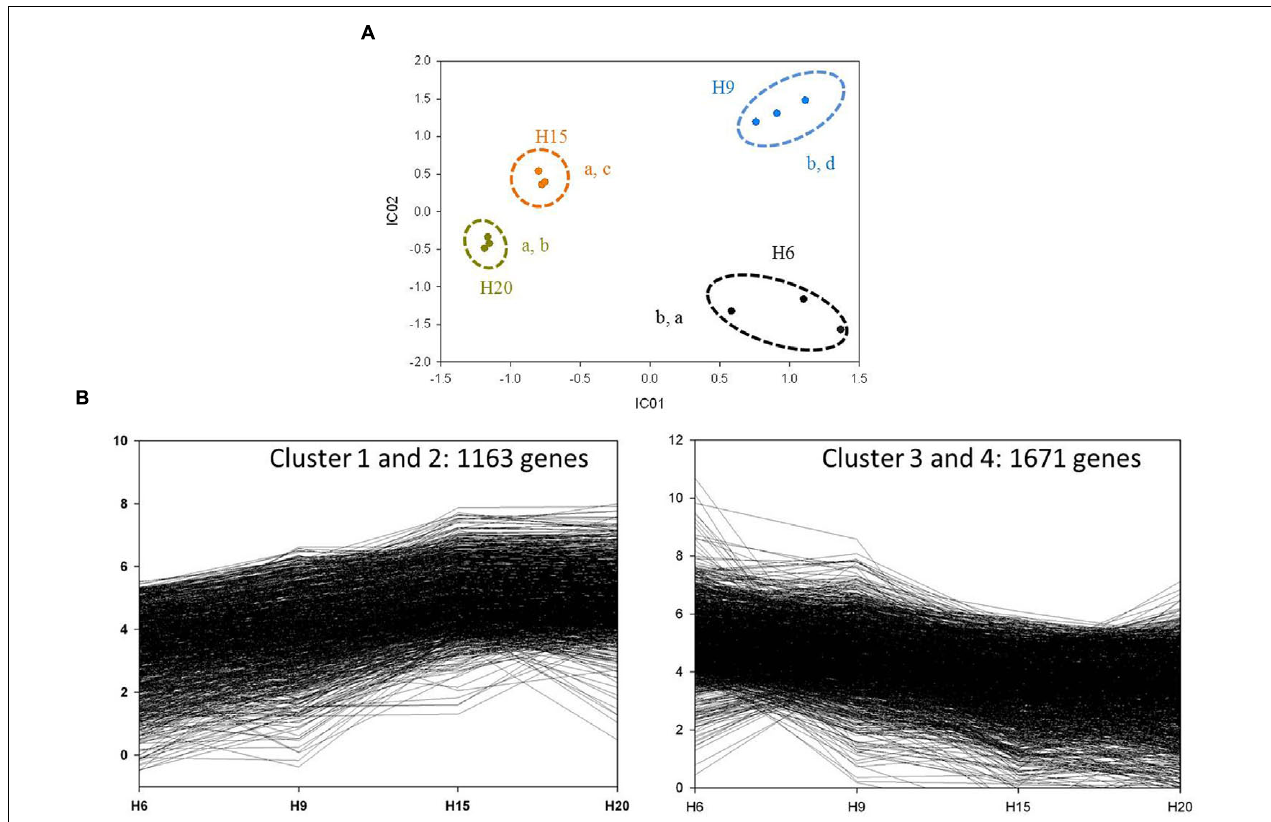
FIGURE 6 | General analysis of H6, H9, H15, and H20 transcriptomes. (A) ICA of H6 (black dots), H9 (blue dots), H15 (orange dots), and H20 (dark yellow dots). Variance explained by the two independent components: 89.36%. The three biological replicates of each time point are surrounded by a dotted line. Letters correspond to homogeneous groups determined by the Tukey post hoc test on IC1 and IC2 coordinates, respectively. (B) Clusters with up-regulated and down-regulated genes through the time-points.